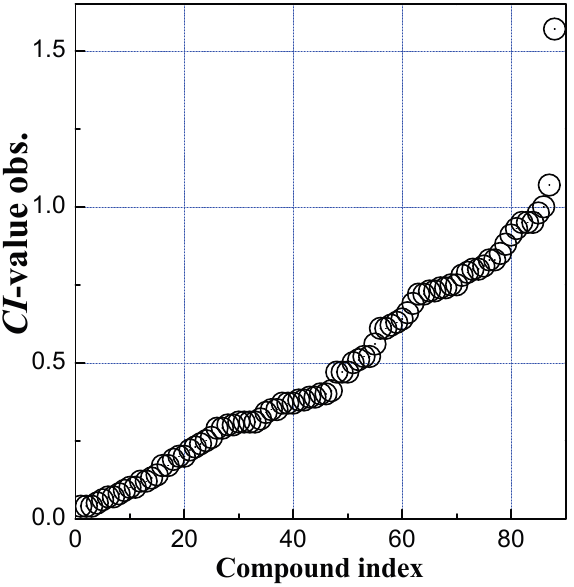
Figure 4. Distribution of the CI value observed of 88